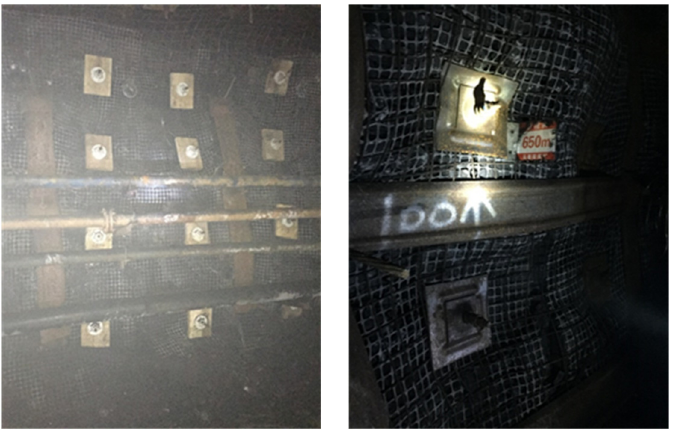
Figure 21. The actual state of displacement of surrounding rock in tail entry 3105.